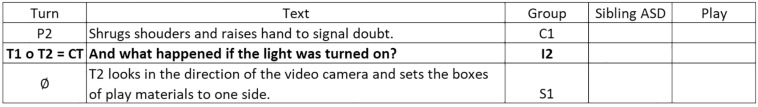
CT – Significant pattern example.